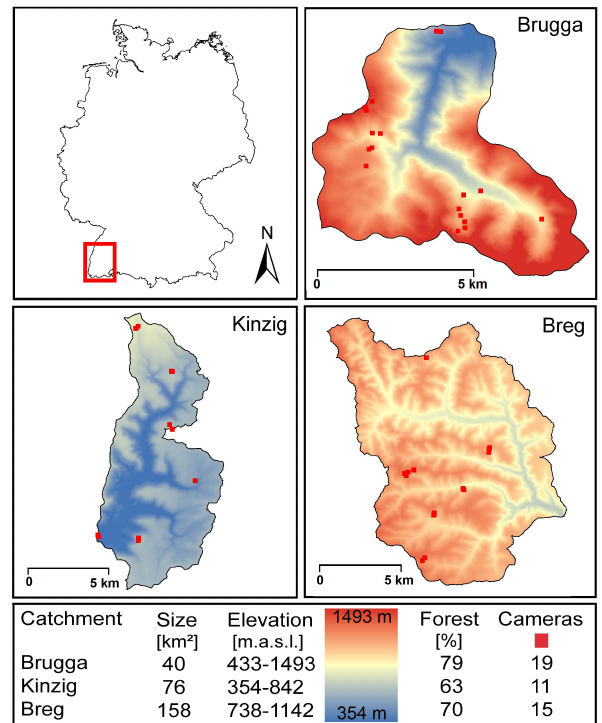
Fig. 1. The three study catchments in the Black Forest, southwest Germany showing the locations of the camera